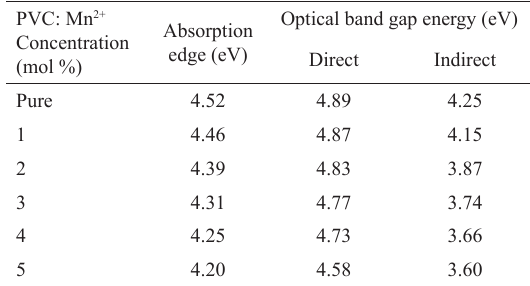
Where E is the band gap, C is constant, is the frequency g of light and h is the Planck’s constant. The intercept on the energy axis on extrapolating the linear portion of the curves to zero absorption value may be interpreted as the value of direct band gap (Figure 7). For pure PVC film the direct band gap lies at 5.26 eV while for Mn 2+ doped films the values are found to decrease from 5.23 to 5.06 eV (Table 1). For indirect transitions, which require photon assistance, the